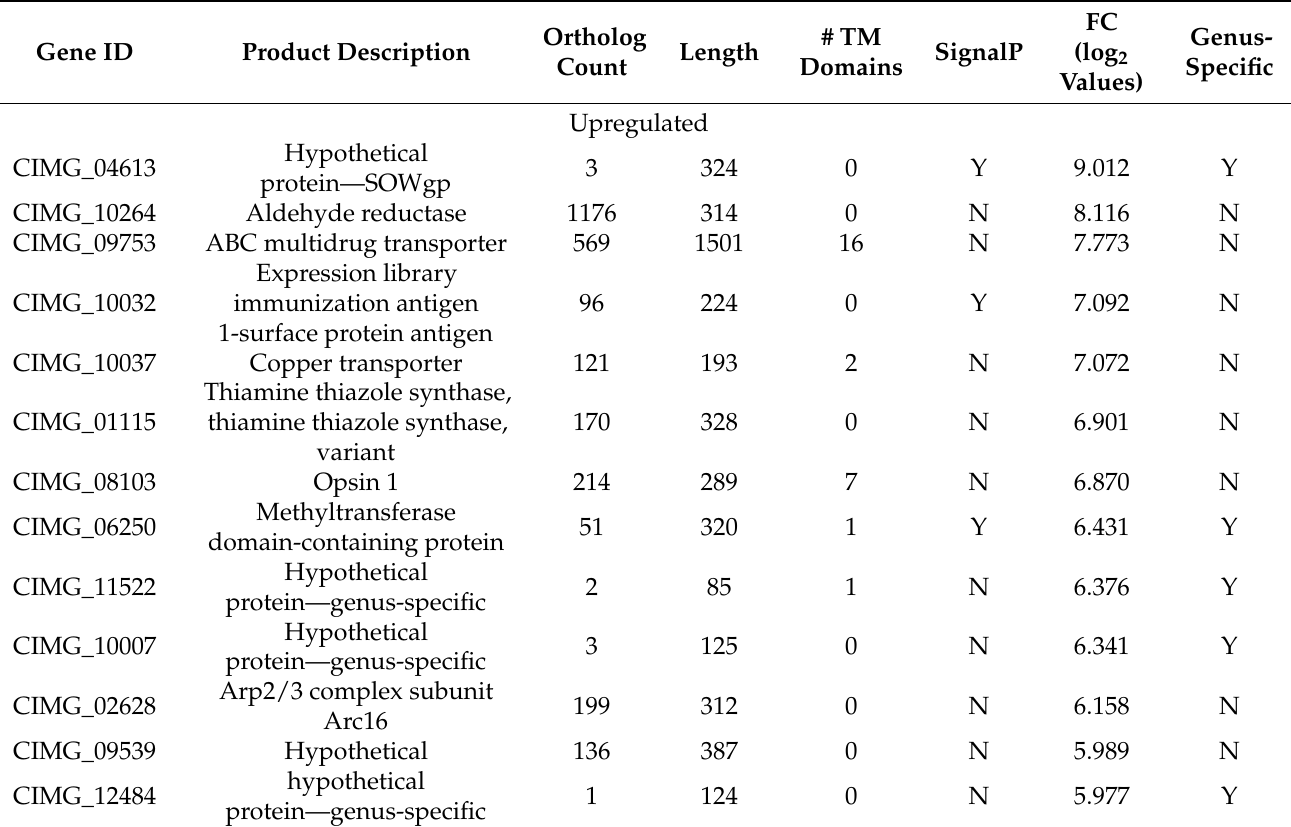
Table 1. Most differentially expressed genes in young spherules compared to mycelia.